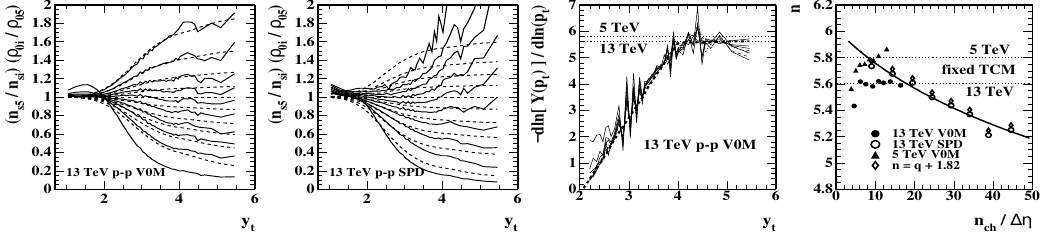
( y ) in ratio to reference spectrum X spectra X t i t